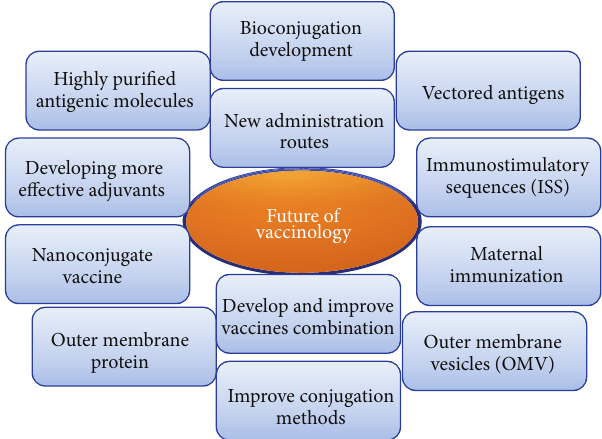
Figure 6: The most important fields in the future of vaccinology as a whole and Hib vaccines in